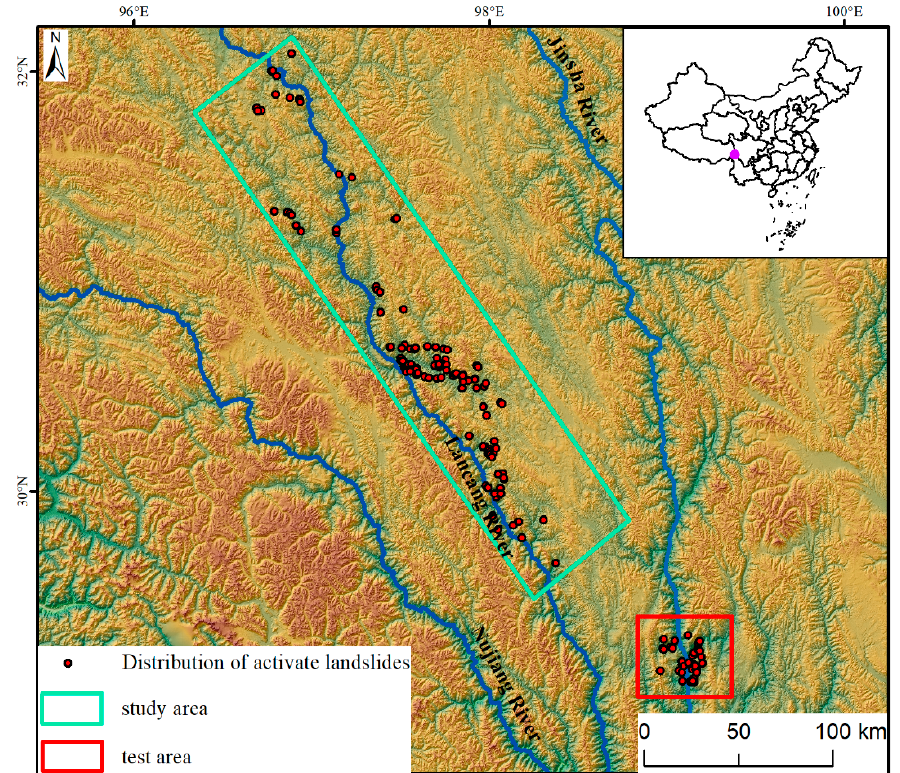
Figure 1. Geographical location map of the research area. The research area is comprised of a study area (cyan frame) and an independent test area (red frame). Red points represent active landslides through manual interpretation.